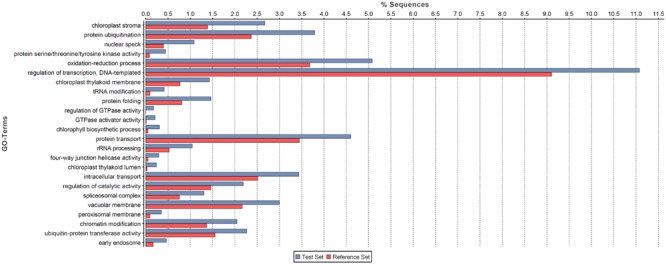
Functional analysis of NATs in pokeweed. GO enrichment analysis was conducted on all NATs (Test Set) against the raw pokeweed transcriptome assembly (Reference Set). Enriched terms (FDR < 0.001) are listed in order of increasing significance (bottom to top).